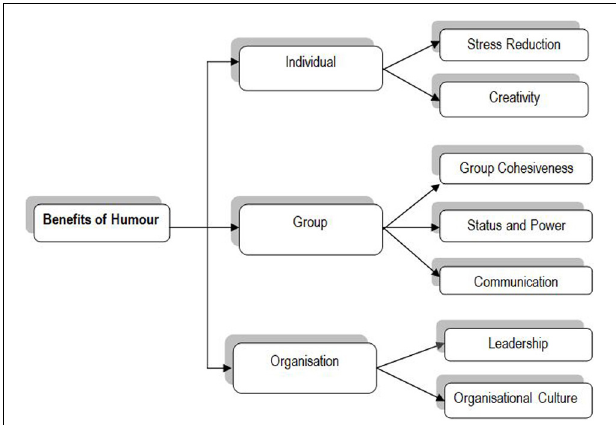
FIGURE 1 | Benefits of humor based on Mathew and Vijayalakshmi